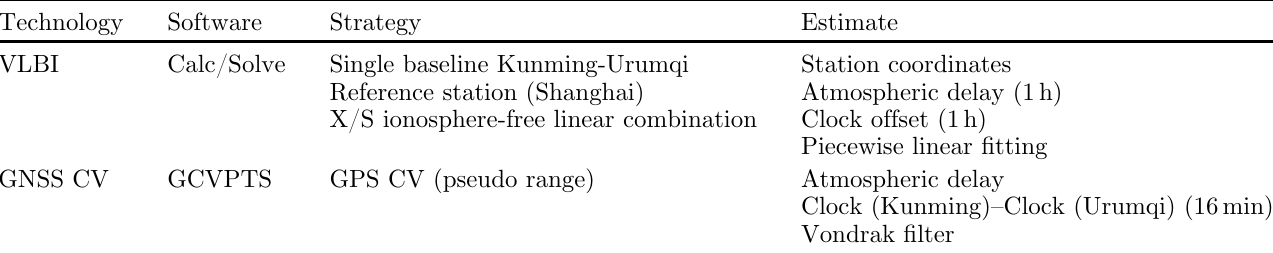
Table 1. Data processes and analysis of GPS CV and VLBI.